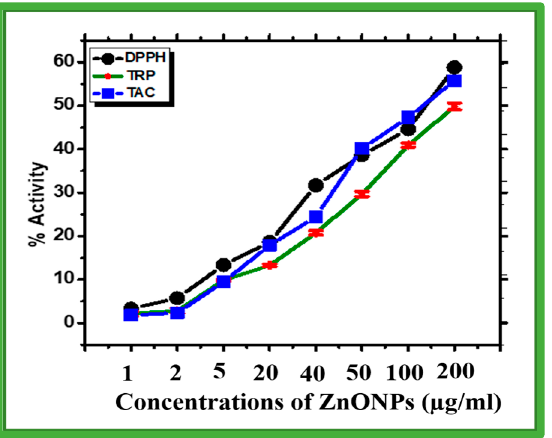
Figure 6. Antioxidant activities (DPPH, TRP, and TAC) of biosynthesized zinc oxide NPs. The data in this figure depict the mean of three replicates .